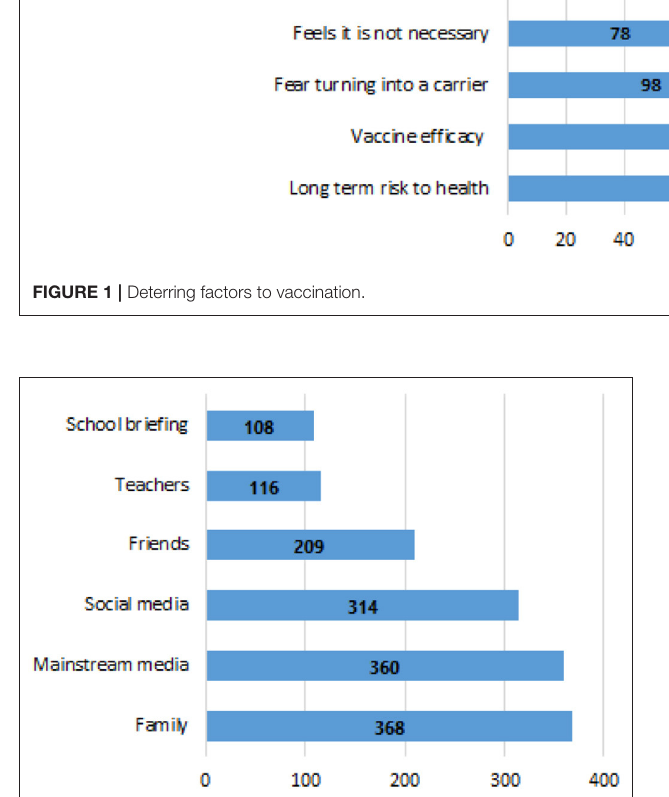
FIGURE 2 | Source of vaccination